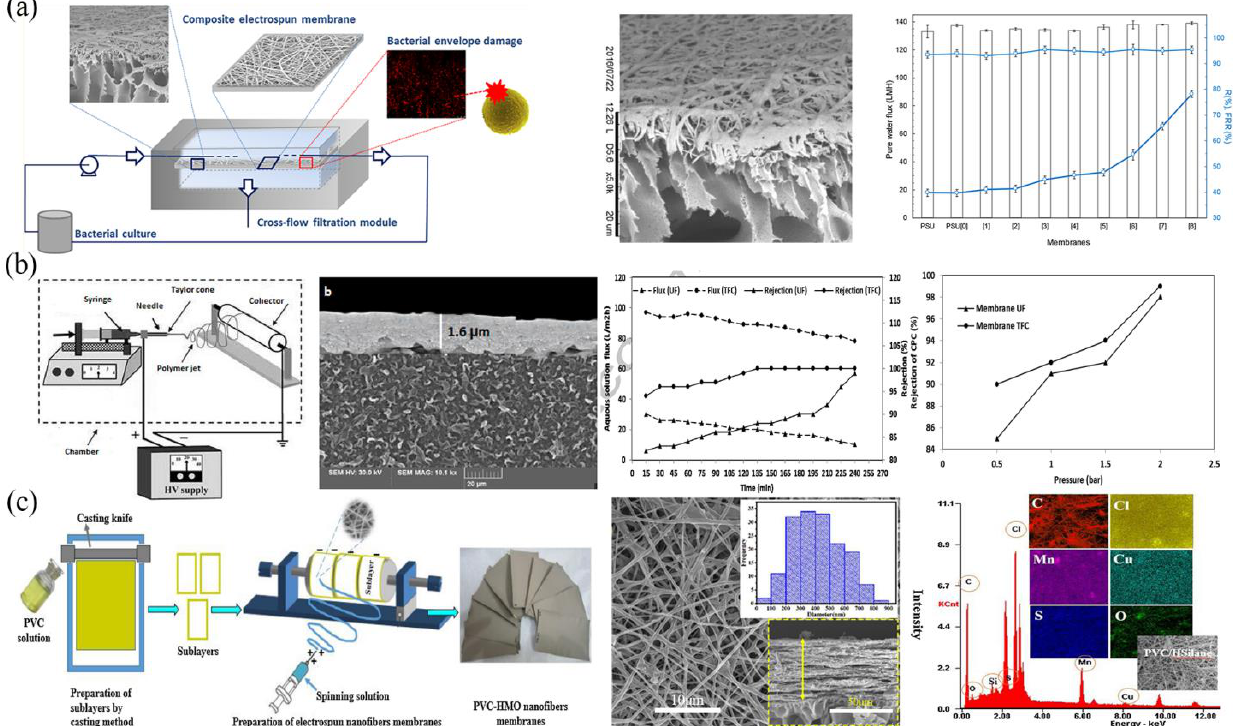
Figure 4. Preparation process, microstructure, and properties of UF membranes: ( a ) PAA/PVA-PSF membrane. Reprinted with permission from Ref. [64]. Copyright 2018 American Chemical Society. ( b ) PEI/PAN membrane. Reprinted with permission from Ref. [65]. Copyright 2017 Elsevier Ltd. ( c ) PVC/MnO membrane. Reprinted with permission from Ref. [66]. Copyright 2020 Elsevier Ltd.